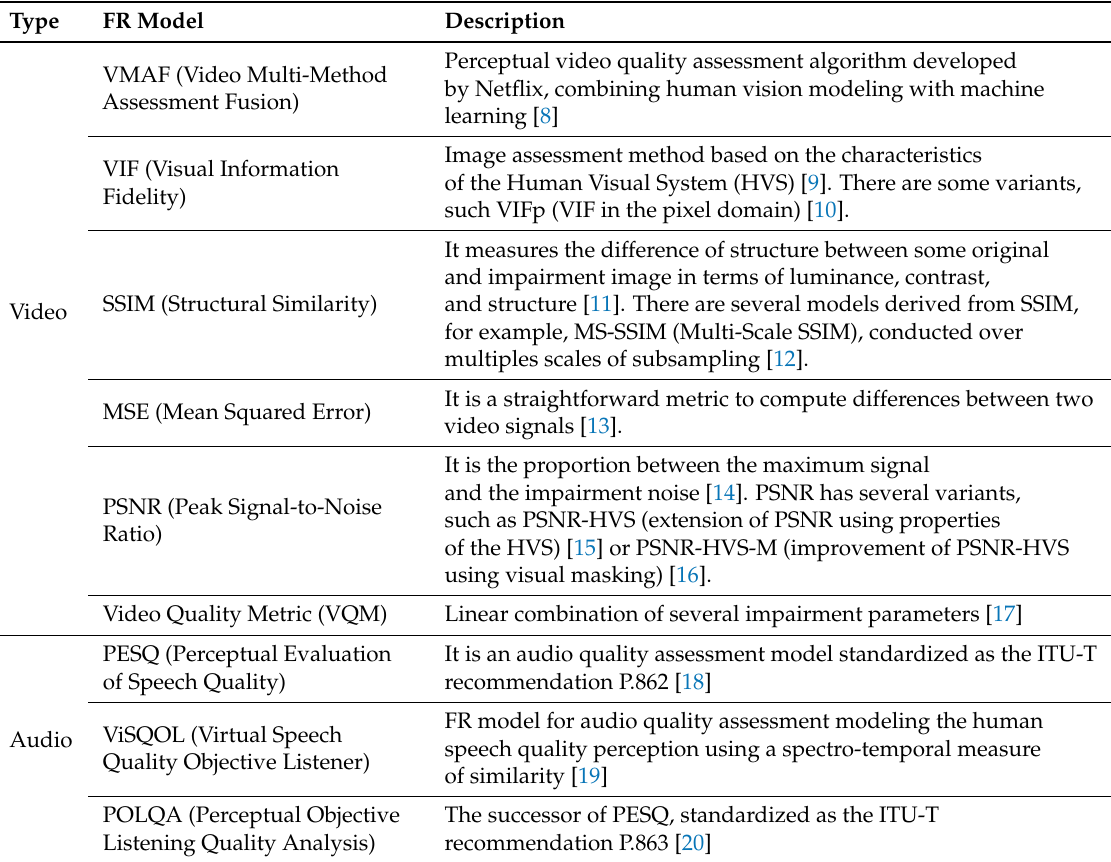
Table 1. Summary of Full-Reference (FR) models for audio and